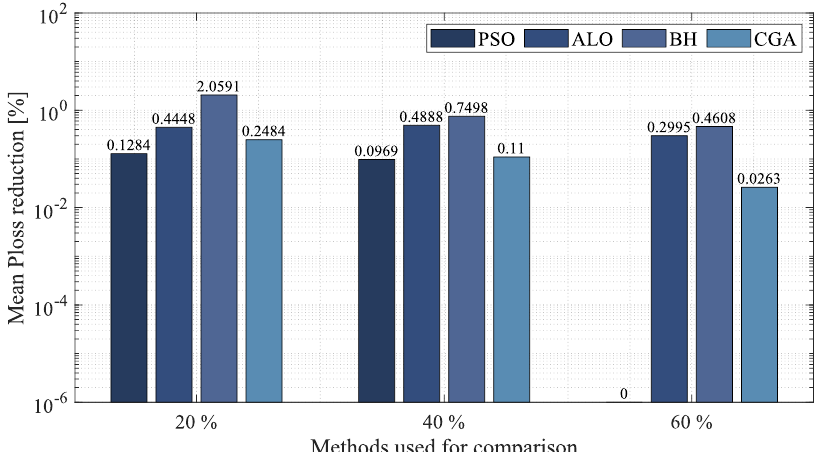
Figure 7. Percentage of reduction of average power losses obtained by the MVO in the 10-node radial test system compared to other methodologies.